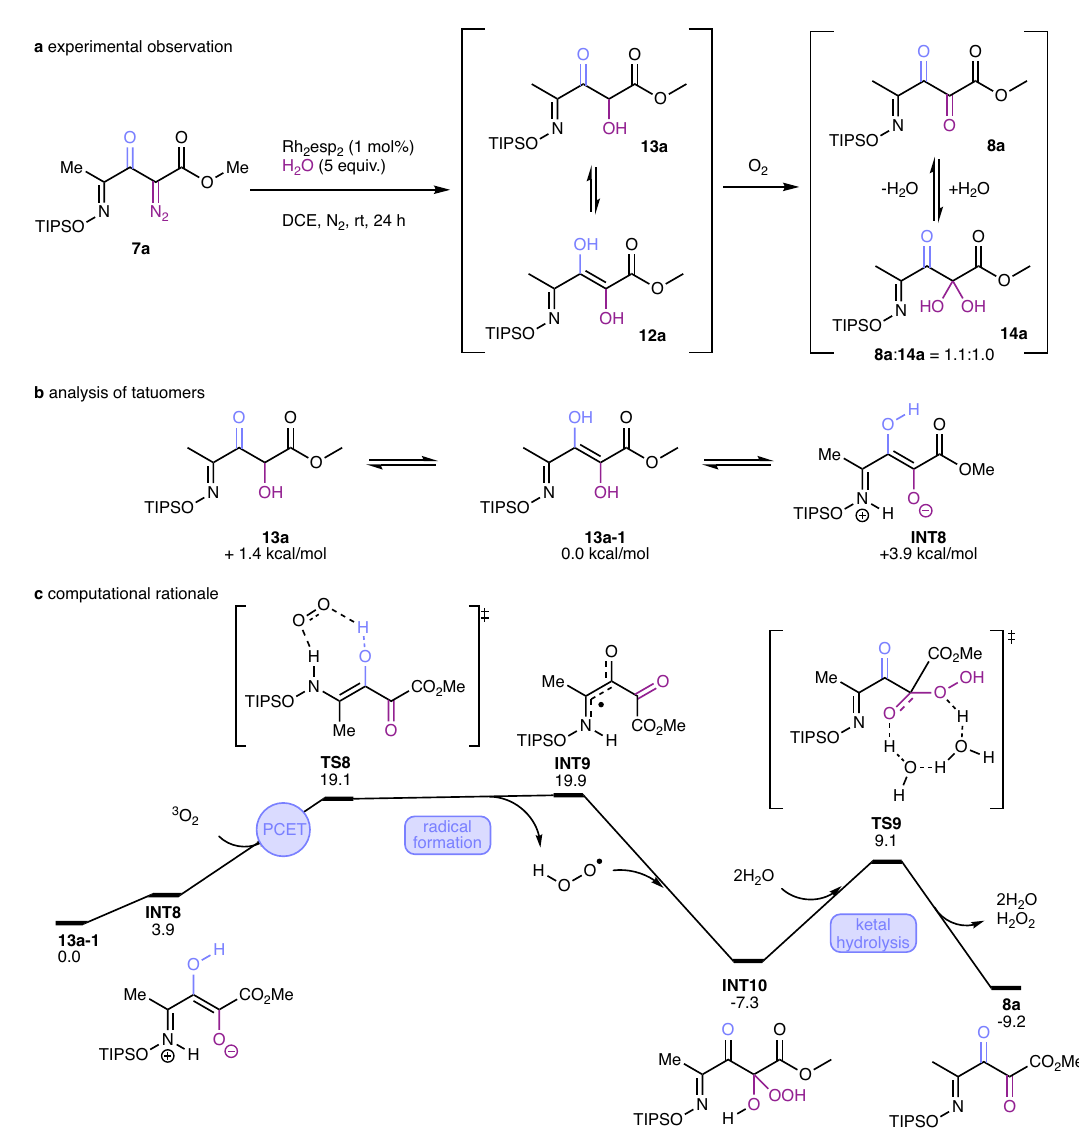
Fig. 5 | Reaction of a silyl-protected 1,2,3,4-tetracarbonyl compound in a rhodium-catalyzed carbene transfer reaction with water. a Experimental observation. b Analysis of tautomers. c Computational